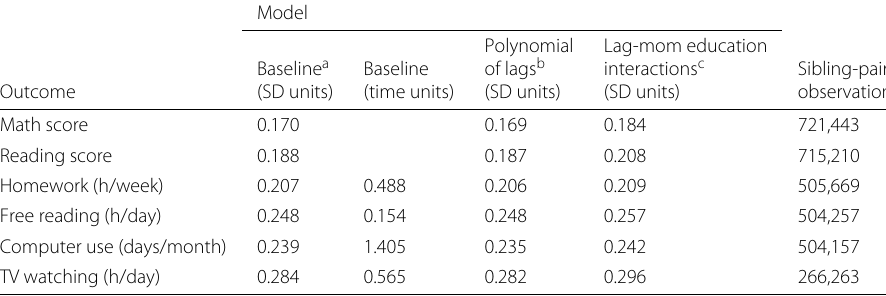
Table 2 Standard deviation of family innovations with model